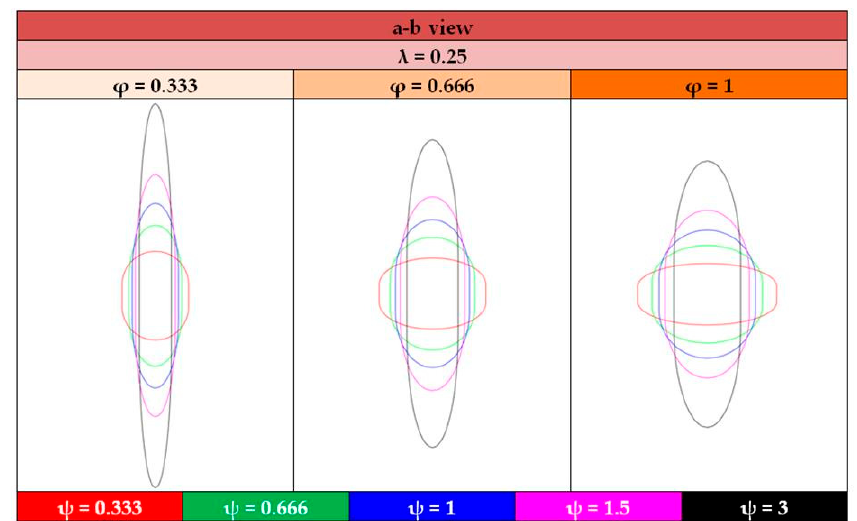
Materials 2023 , 16 , x FOR PEER REVIEW Figure 14. Graphical representation of the a–b view of tank configurations with λ = 0.25. Figure 14. Graphical representation of the a–b view of tank configurations with λ = 0.25. Figure 14. Graphical representation of the a–b view of tank configurations with λ = 0.25.